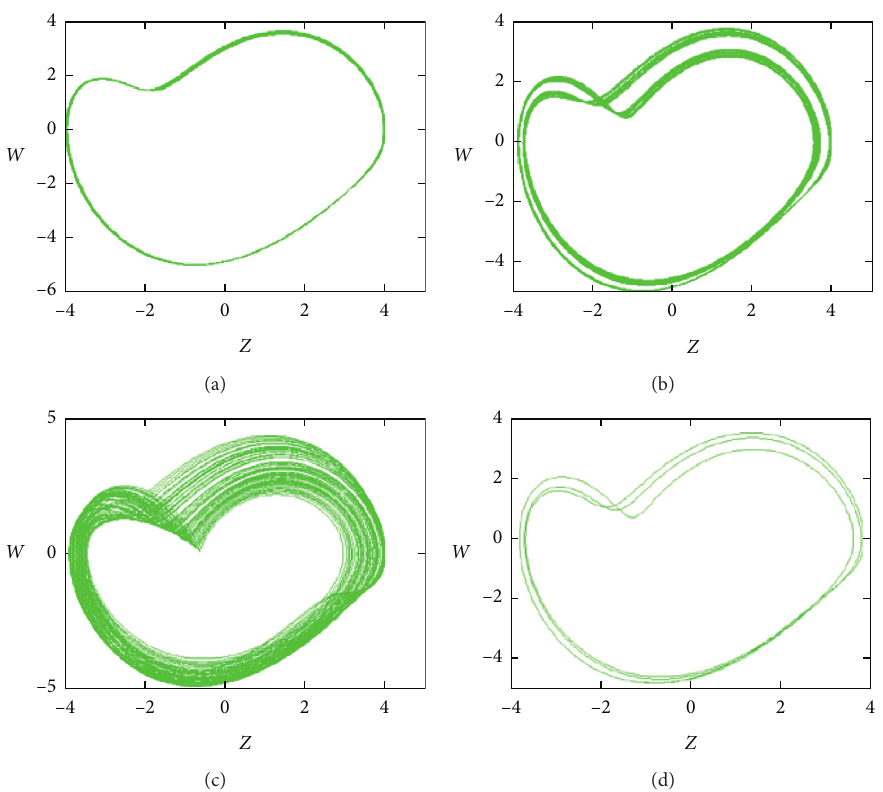
Figure 5: Typical phase portraits of system (1) with (b) � 0.5, (c) � 1, (d) � 0.1 and IC � (0.01, 0.01, 0, 0) on the ( z )-( w ) plane: (a) (a) � 0.88, (b) (a) � 0.8306, (c) (a) � 0.8, (d) (a) � 0.7904.